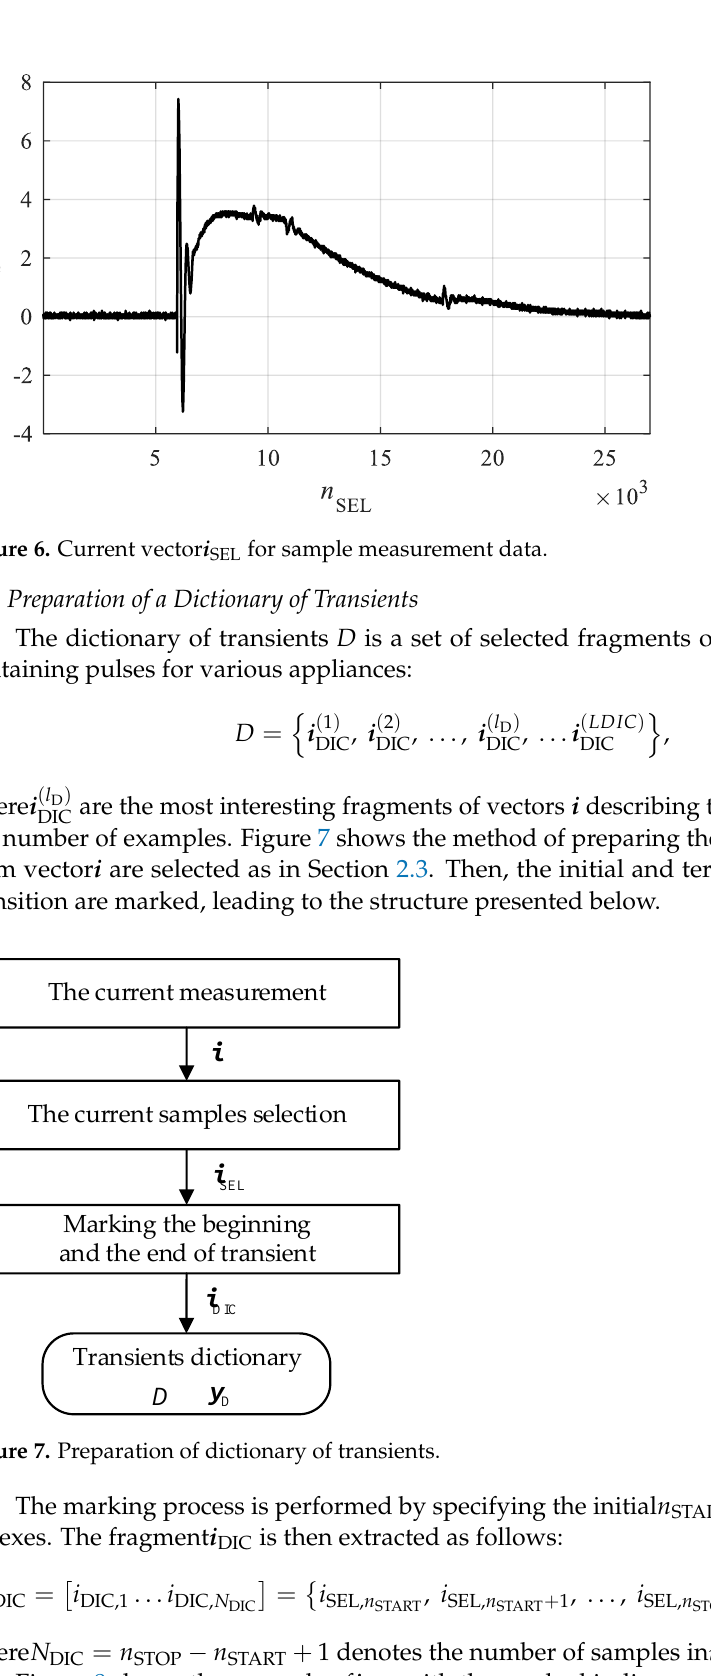
( b ) Figure 8. Current vectors for the sample measurement data: SEL i ( a ) and D I C i